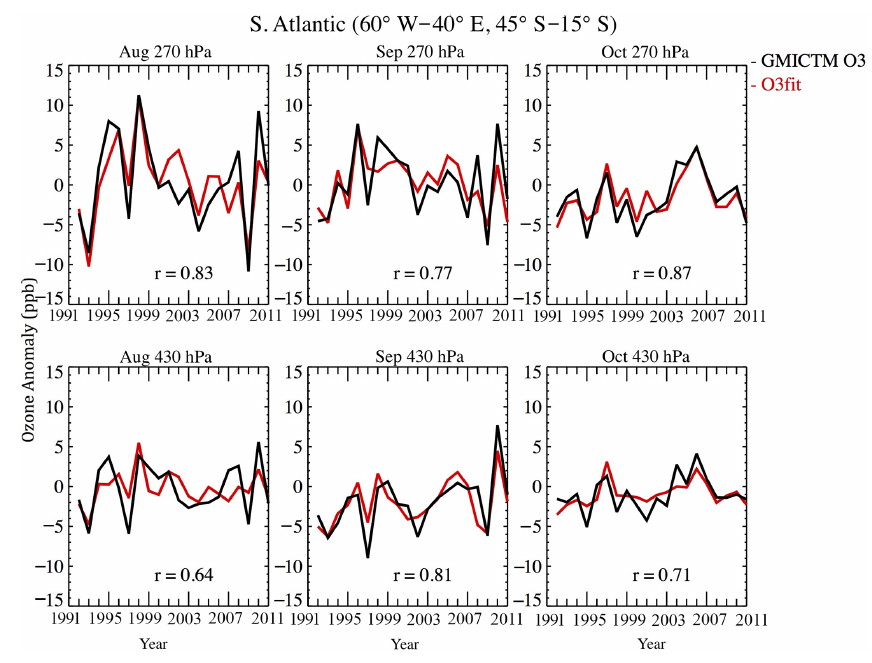
Figure 7. Comparison of the simulated ozone anomalies and the calculated ozone anomalies relying on two predictor variables: StratO 3 and EmissO 3 at 270 and 430hPa over the South Atlantic region. Three panels show results from August (left), September (middle), and December (right) from 1992 to 2011. Unit for y axis is parts per billion (ppb).